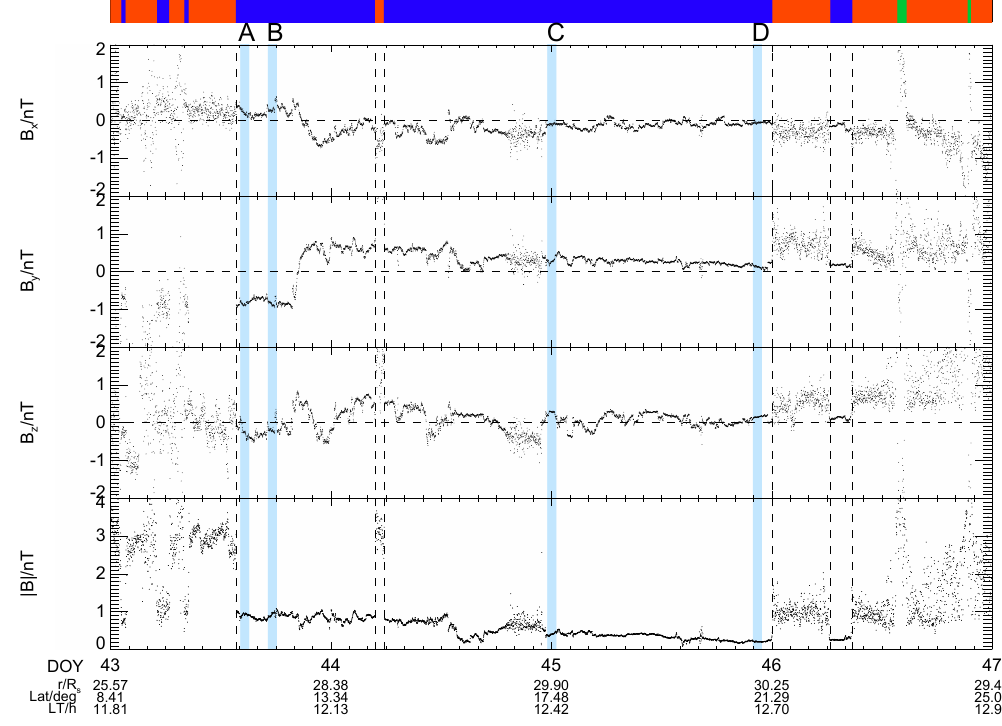
Fig. 1. Cassini magnetic field data for DOY 43 to 46 of 2008. From top to bottom the data panels show the three components of the magnetic field in KSM coordinates, and the field magnitude. In the colour-coded region identifier at the top of the plot green corresponds to the magnetosphere, red to the magnetosheath, and blue to the solar wind. Principal bow shock crossings (red-blue transitions) are identified by vertical black dashed lines. The data at the bottom of the plot give the radial distance ( R S ) , latitude (deg), and local time (h) of the spacecraft. The 1h blue vertical stripes labelled “A” to “D” correspond to the suitably lagged times of four HST imaging intervals. (From Belenkaya et al.,